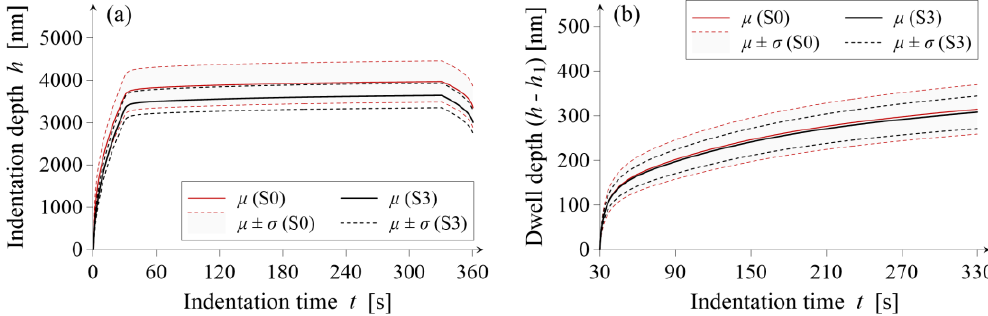
Figure 11. ( a ) Average indenter immersion during all the indentation phases and (b) average immersion in the creep phase only. Results for sample S3 versus the reference sample S0.